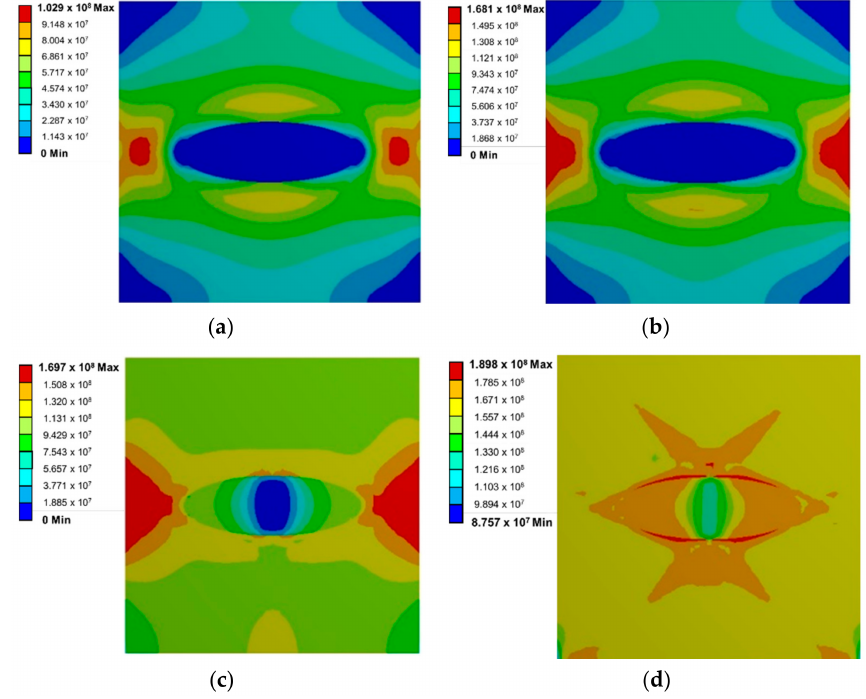
Figure 5. Stress distribution around the oval SiO 2 microparticle for ( a ) step number 10, ( b ) step number 20, ( c ) step number 40, and ( d ) step number 50.